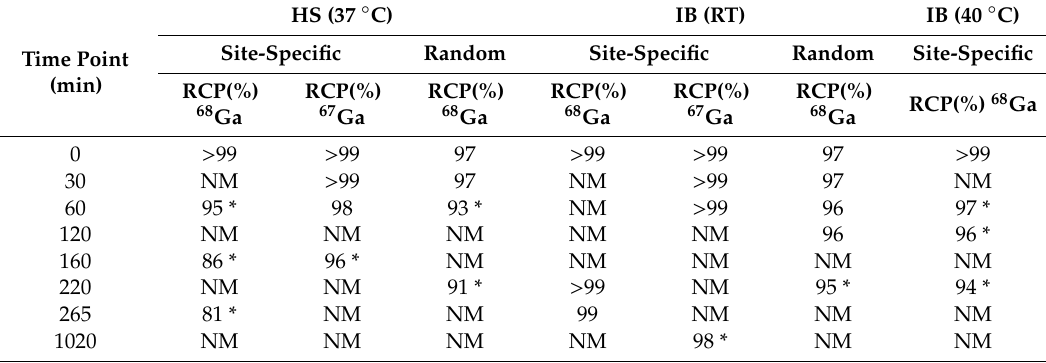
Table 2. Stability expressed as radiochemical purity (RCP) of the 67 / 68 Ga-labeled NOTA-(hPD-L1) Nbs. NOTA-(hPD-L1) Nbs site-specifically labeled with 68 Ga or 67 Ga, or randomly labeled with 68 Ga, in human serum (HS) at 37 ◦ C or in injection bu ff er (IB) at room temperature (RT) or 40 ◦ C. Lowest RCP value obtained from radio-SEC (*) or radio-iTLC is reported. Time points that were not measured are noted as